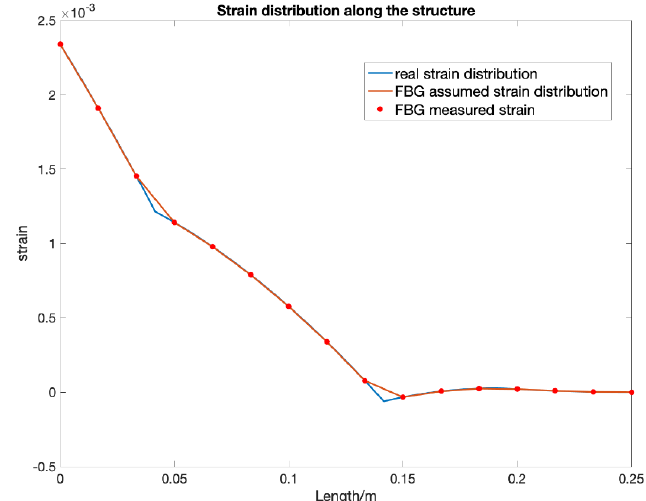
Figure 15. Strain distribution along the cantilever for complex loading.